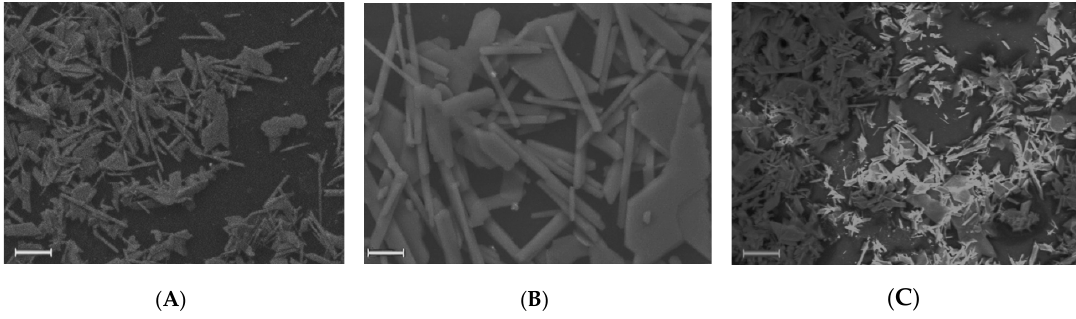
Figure 7. SEM images of gypsum deposit on membrane surface at the end of the Blank C ( A,B ) and GSI ( C ) experiment. Scale marker corresponds to 20 ( A,C ) and 5 ( B ) μm.